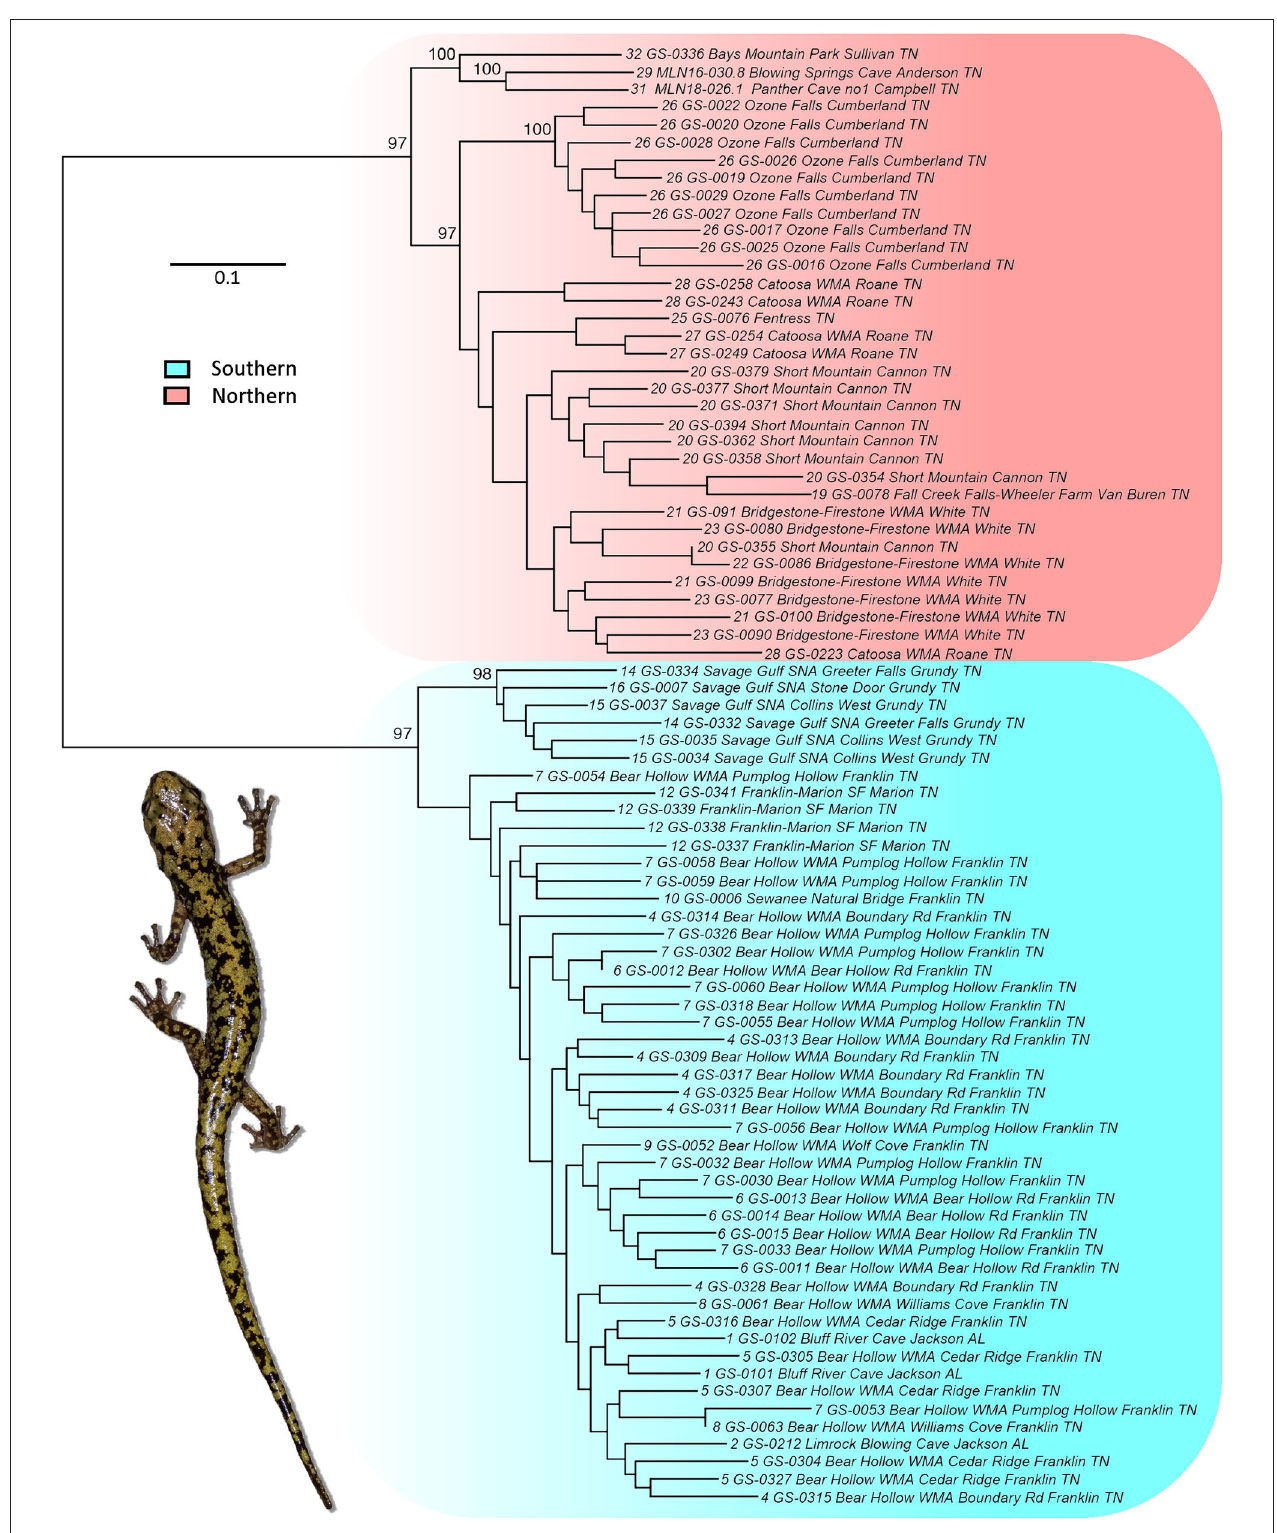
FIGURE 4 | Maximum-likelihood phylogram for the nuclear SNP dataset generated in IQ-TREE. Nodes with > 95% support are labeled. Site and sequence labels correspond to those in Table 1 ; Supplementary Table S1 . Major lineages are highlighted.